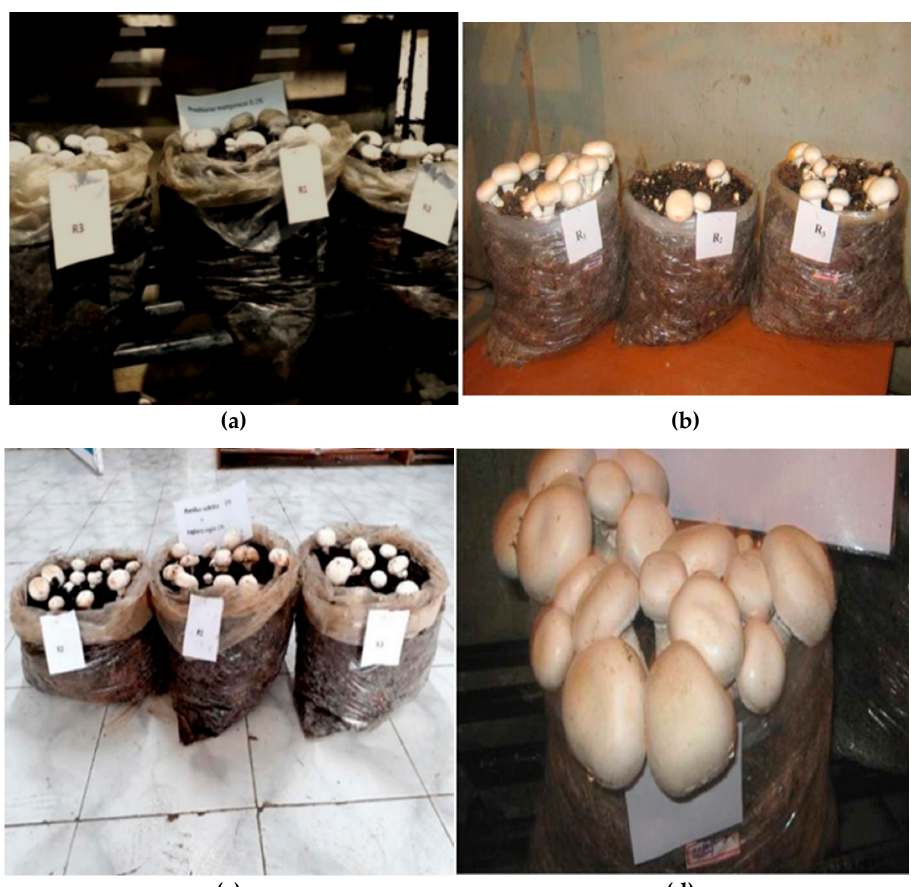
Figure 10. Effect of fungitoxicants under in vivo conditions: ( a ) experiment plan of layout; ( b ) prochloraz manganese treatment; ( c ) carbendazim treatment; ( d ) casing soil (uninfested). Table 9. Impact of systemic fungitoxicants in casing on percent intensity of green mold disease.